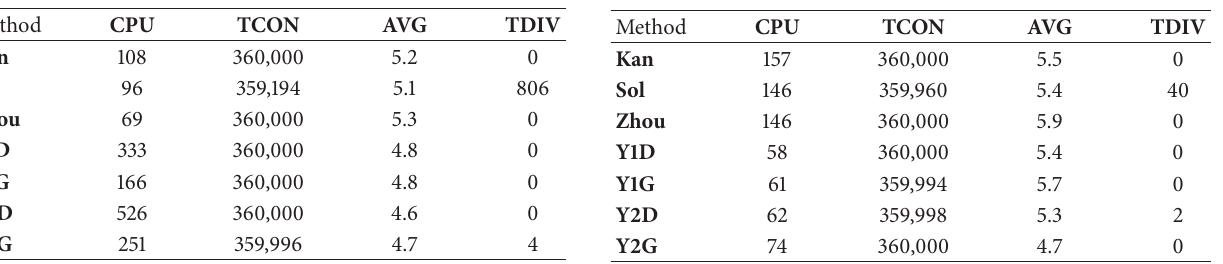
Table 5: Typical Example 2 with 𝑃 2 (𝑧) = 𝑧 3 (𝑧 + 1) , 𝑚 = 3 .